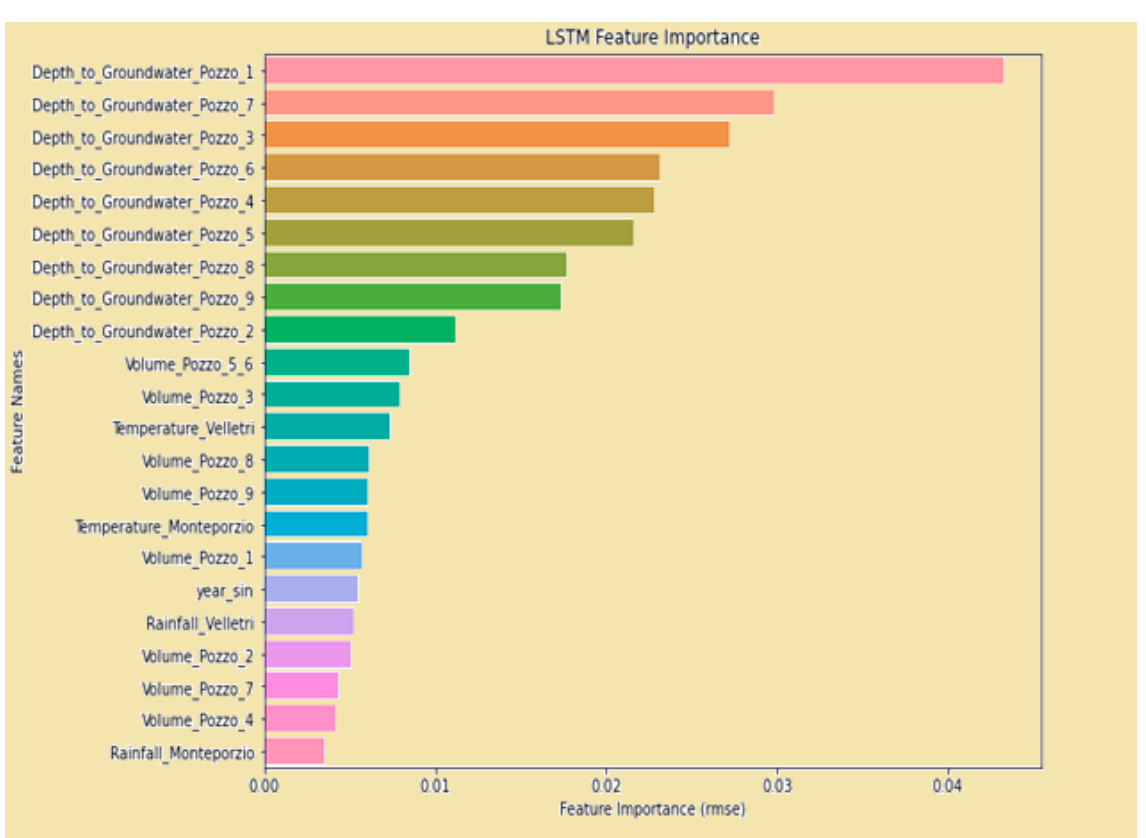
Figure 5. LSTM feature importance for Auser-Aquifer.